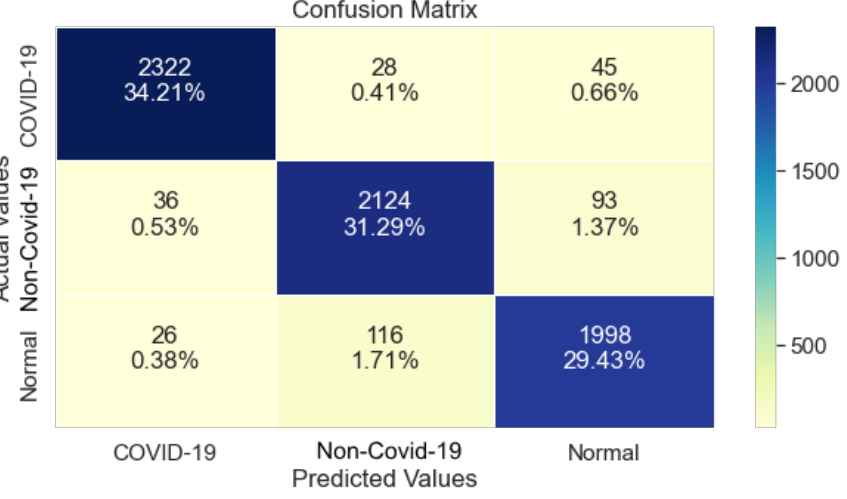
Figure 7. InceptionV3 Confusion Matrix.